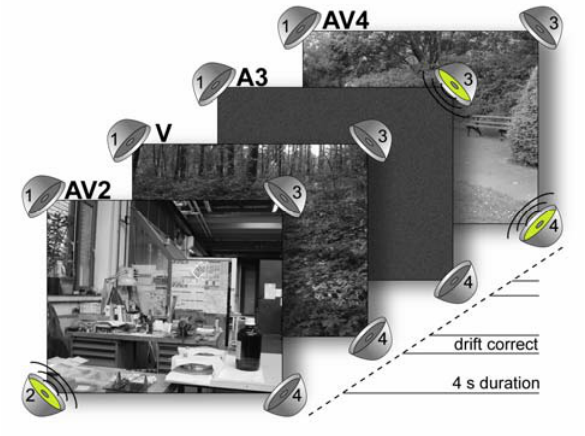
Figure 2. Procedure for the eye-tracking experiment. Each of the 96 trials lasted for four seconds and consisted of either an image (V), a sound with white noise image displayed (A1-4), or simultaneously presented image and sound (AV1-4). Sounds were spatialised to one of four locations, corresponding approximately to the corners of the screen (1: top-left, 2: bottom-left, 3: top-right, 4: bottom-right). Drift correction was performed before presentation of each stimulus. See text for further